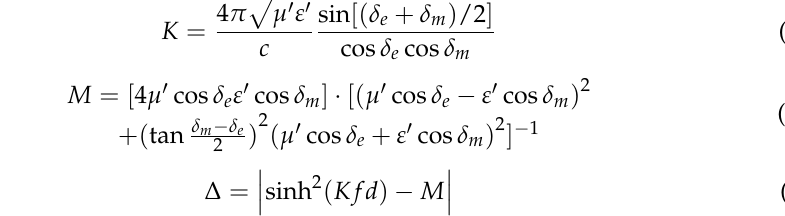
Figure 10. The heat source analysis of asphalt mixtures with different steel slag contents with SA ( a ) and SB ( b ). and SB ( b